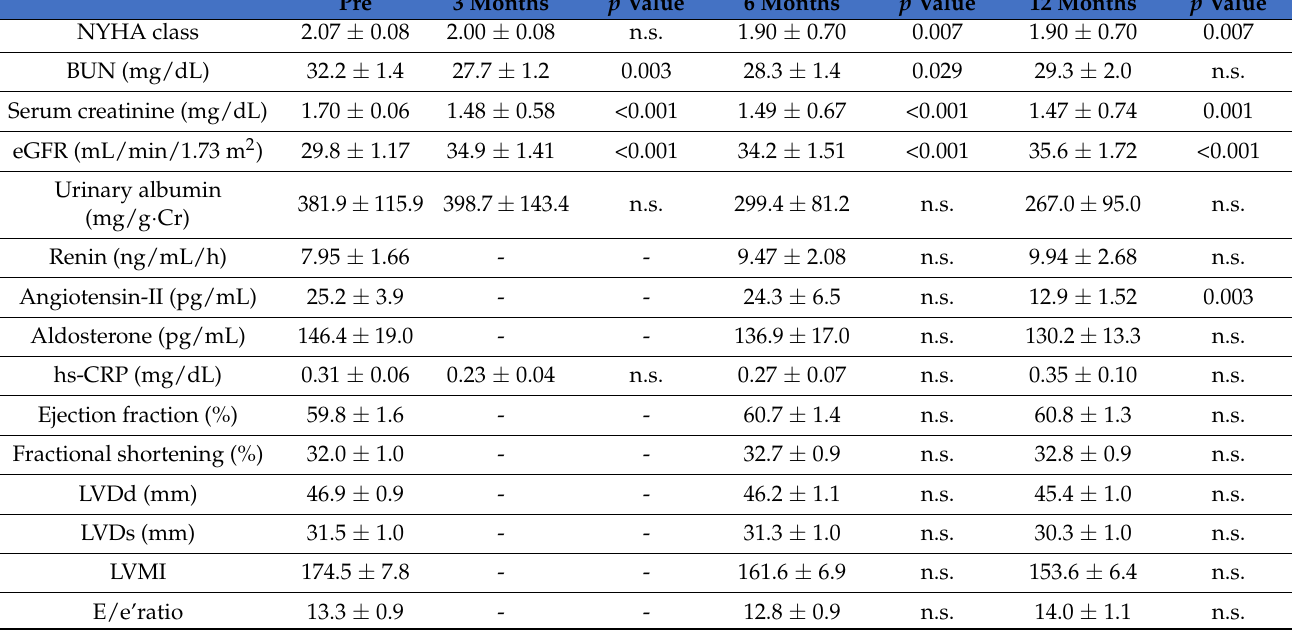
Table 3. Changes of each blood and urine test and echocardiographic